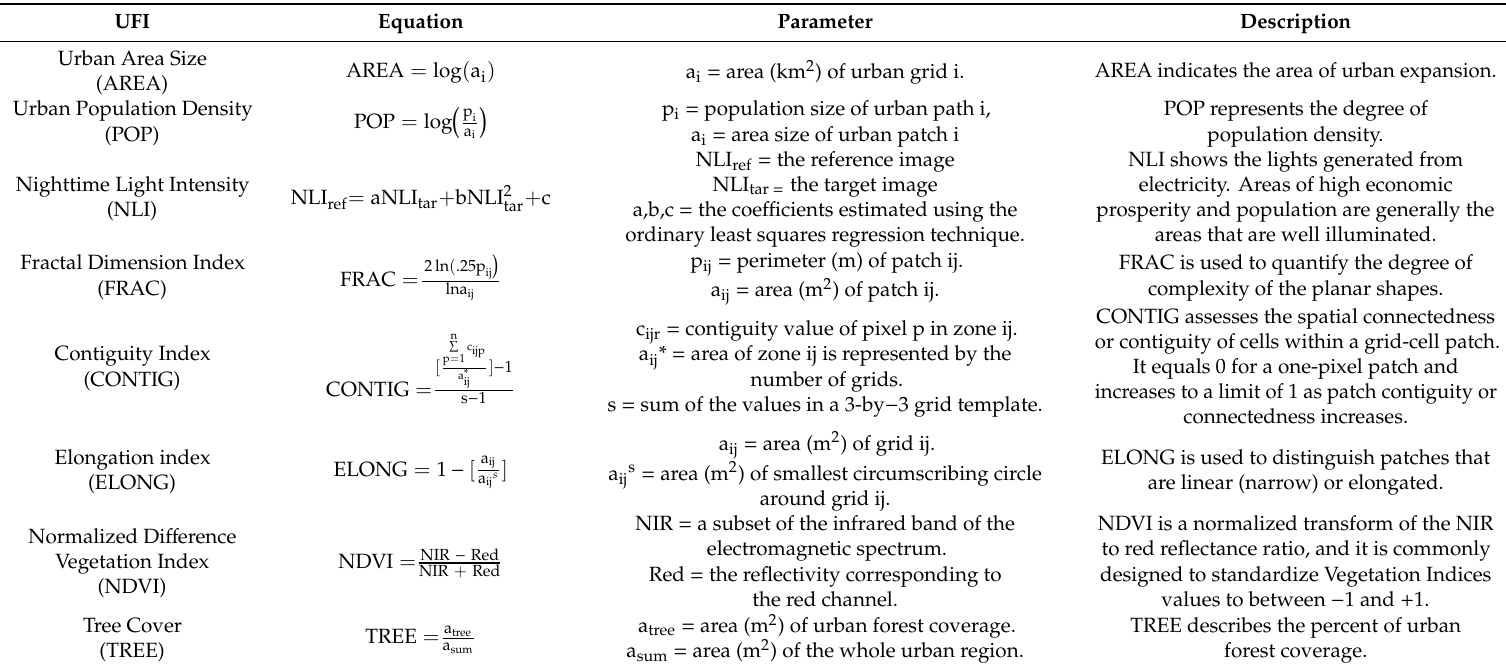
Table A1. Calculation methods and descriptions of the urban form indicators used in this study.